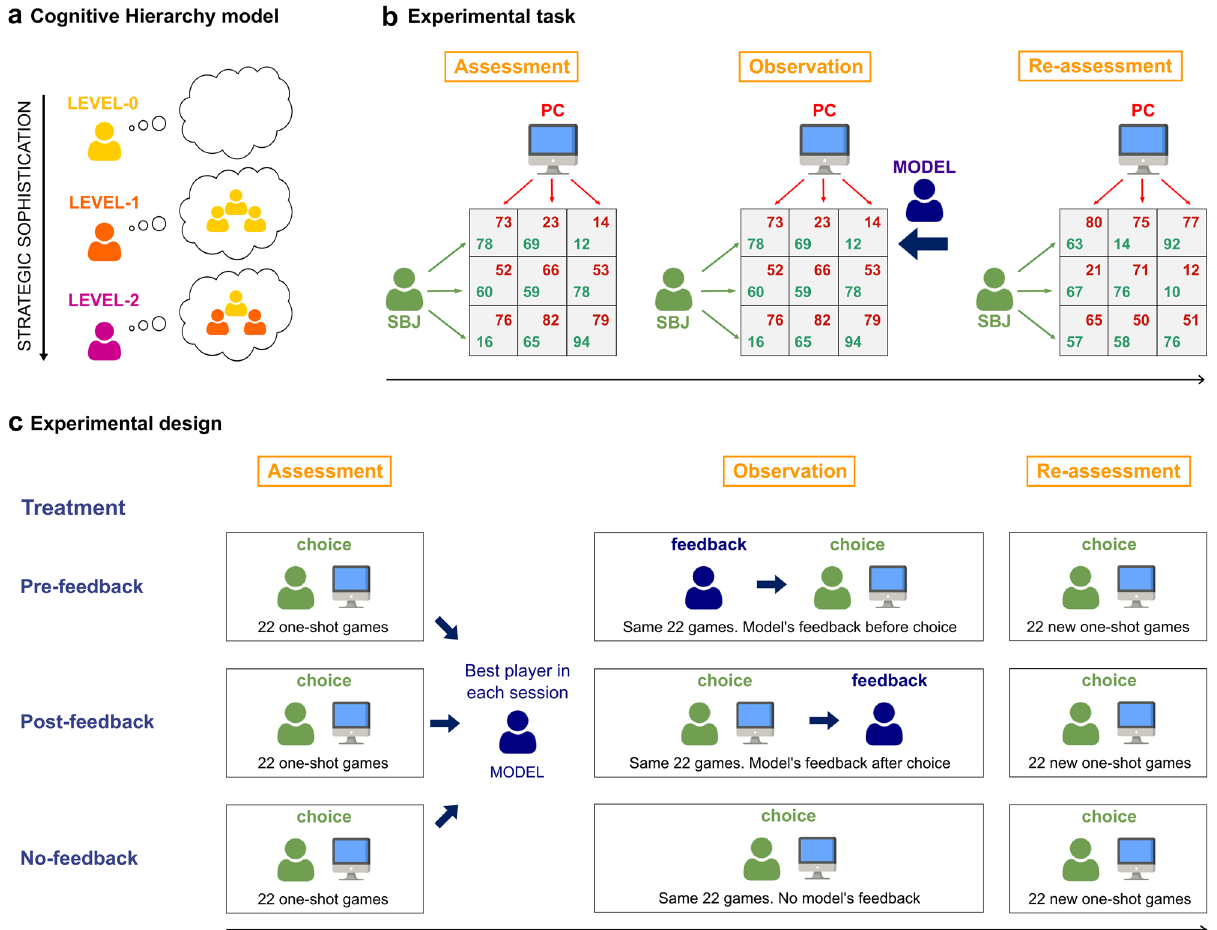
Figure 1. ( a ) Graphical illustration of the Cognitive Hierarchy (CH) model. CH models the strategy space of players through a hierarchical structure characterized by increasing levels of strategic sophistication. The hierarchy starts with players who play randomly and do not form any beliefs about the choices of their counterparts (level-0). The second level in the hierarchy predicts level-1 players, who best respond to the belief that the counterparts are level-0; then CH predicts level-2 players, who best respond to the belief that the population of potential opponents is a mixture between level-0 and level-1, and so on, increasing the number of steps of strategic sophistication. ( b ) Experimental task. Participants were tested in groups. Every participant underwent three consecutive experimental phases (Assessment, Observation and Re-Assessment). In all phases, participants played one-shot 3 × 3 normal form games with a computer algorithm (PC) with fixed but unknown behavior (level-1 strategy). Participants played as row player and had to select one of the three rows of the game matrix, whereas the artificial agent played as column player and chose one of the matrix columns. The combination of the two players’ choices determined the game outcome (green payoff for the participant, red payoff for the artificial agent). Participants did not receive feedback on the game outcomes. In the Observation phase, participants received feedback on the choices of the best player in the Assessment phase (the model). The feedback consisted in a black arrow in correspondence to the row selected by the model. ( c ) Experimental design. Participants in a specific experimental session were assigned to one of three experimental treatments (No-feedback, Pre-feedback, Post-feedback). The Assessment phase was identical for all the experimental treatments: participants played 22 one-shot games with the same artificial agent, without any feedback. Then participants in all treatments were told if they were the best player in the session (or not). In the Observation phase, participants received different types of feedback based on the experimental treatment. In the Pre-feedback treatment, participants could observe the decision taken by the model (the best player in the Assessment phase) in that game as soon as the game matrix appeared, before they made their choice. Conversely, participants in the Post-feedback treatment could see the model’s feedback only after they made their decision. In the No-feedback treatment, participants did not receive any feedback on the model’s choices. Eventually, participants in all treatments underwent the Re-assessment phase, in which they played 22 new games without receiving the model’s feedback, as in the Assessment